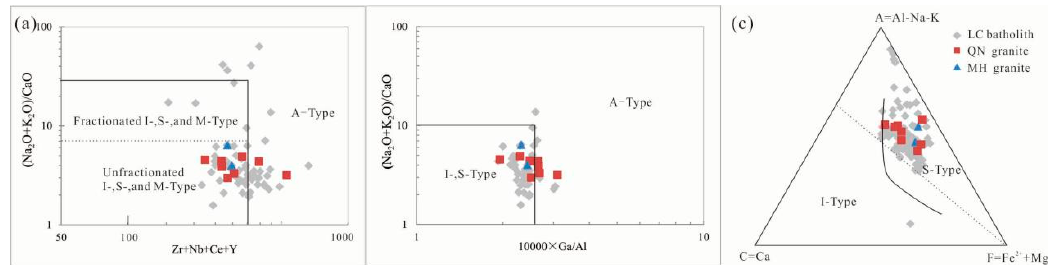
Fig.4 Discrimination diagrams for the Lincang granite